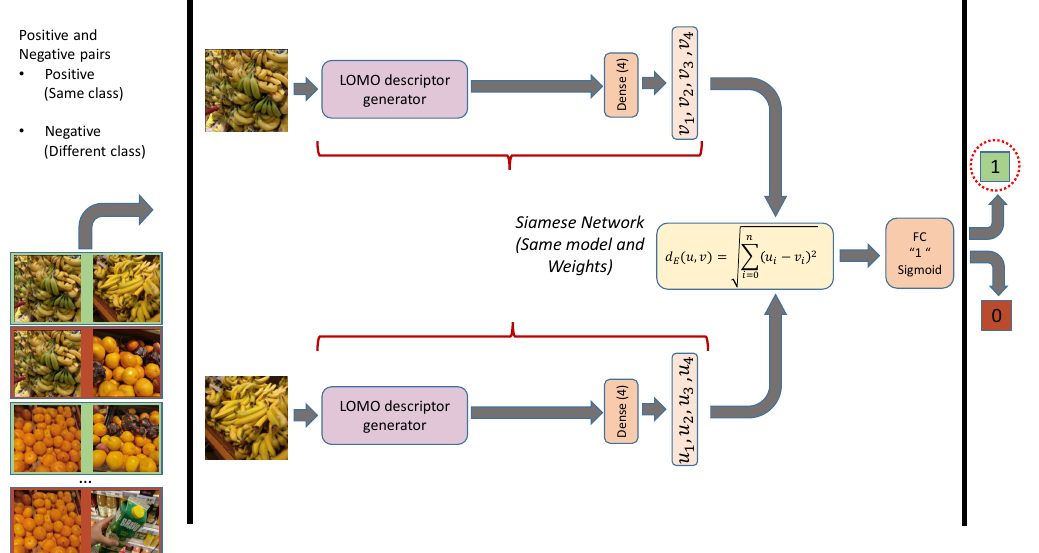
Figure 4. Second approach: Siamese net with LOMO descriptor. LOMO works with 10 × 10 sliding windows, with an overlap of five pixels, to process local blocks in 128 × 48 images. Within each window, two SILTP histogram scales ( SILTP 0.3 and SILTP 0.3 ) and a joint HSV histogram of 8 × 8 × 8 cells are extracted. SILTP τ 4,5 is equal to the concatenation of N binary strings, obtained for N neighborhood pixels equally spaced on a circle of radius R with respect to the pixel ( x c , y c ) . The binary strings are calculated by using the τ scale factor. From k = 0 to k = N − 1, the binary string is ”01” when I k > I c · ( 1 + τ ) , ”10” when I k < I c · ( 1 − τ ) and ”00” otherwise. I k and I c are the gray intensities of pixels k and c , respectively. Figure 5 graphically shows an example of how SILTP is calculated.